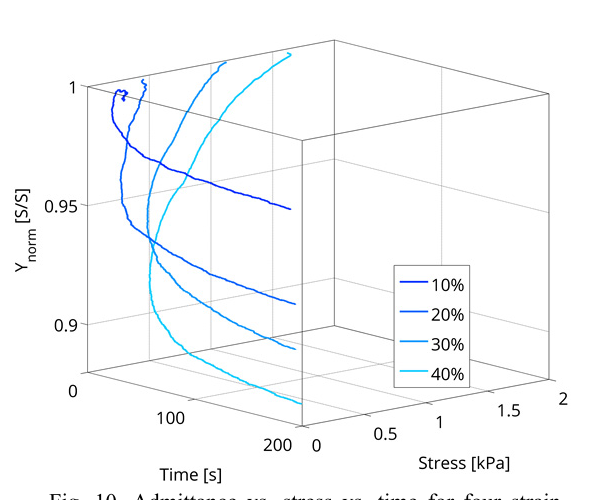
Fig. 10. Admittance vs. stress vs. time for four strain levels. The correlation between admittance and stress comes more sharply into focus when viewed in this